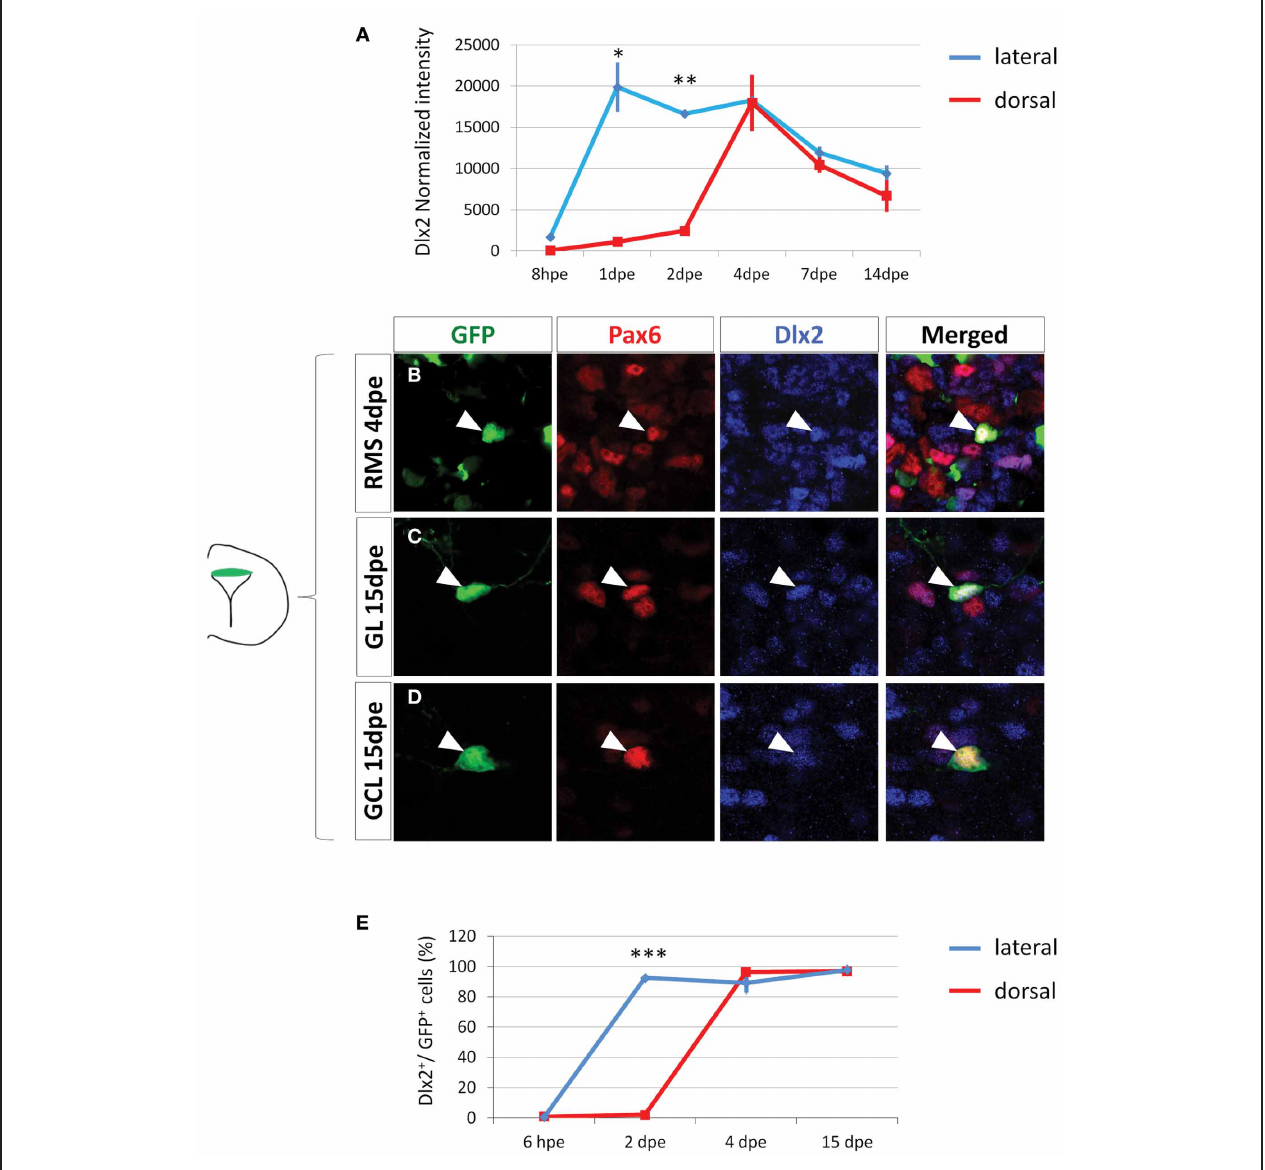
layer (C) and glomerular layer (D) at 15dpe. Arrowheads: GFP + /marker + cells. Note that both in the RMS and the GCL and GL of the OB Dlx2 is co-expressed with Pax6 in dorsally generated GFP electroporated cells. (E) Evolution of Dlx2 expression in dorsal (red) or lateral (blue) GFP + electroporated cells at successive time after electroporation ( n = 3 mice per group). Scale bar: 10 μ